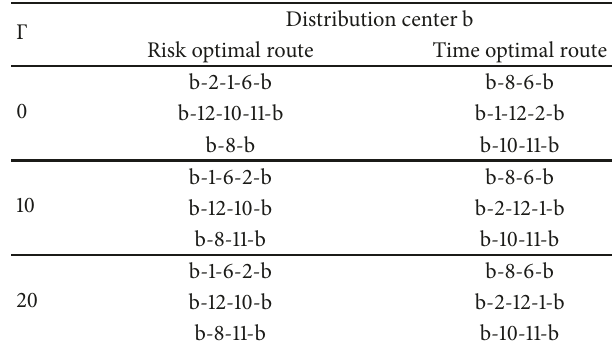
Table 15: Pareto optimal solutions for distribution center b when Γ = 0, Γ = 10 and Γ = 20.